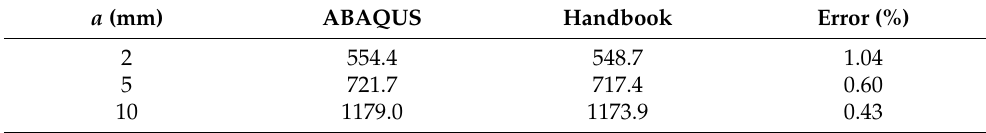
Figure 8. ( a ) Stress nephogram of a = 2 mm. ( b ) Stress nephogram of a = 5 mm. ( c ) Stress nephogram of a = 10 mm. Table 4. Comparison of stress intensity factors calculated by ABAQUS and